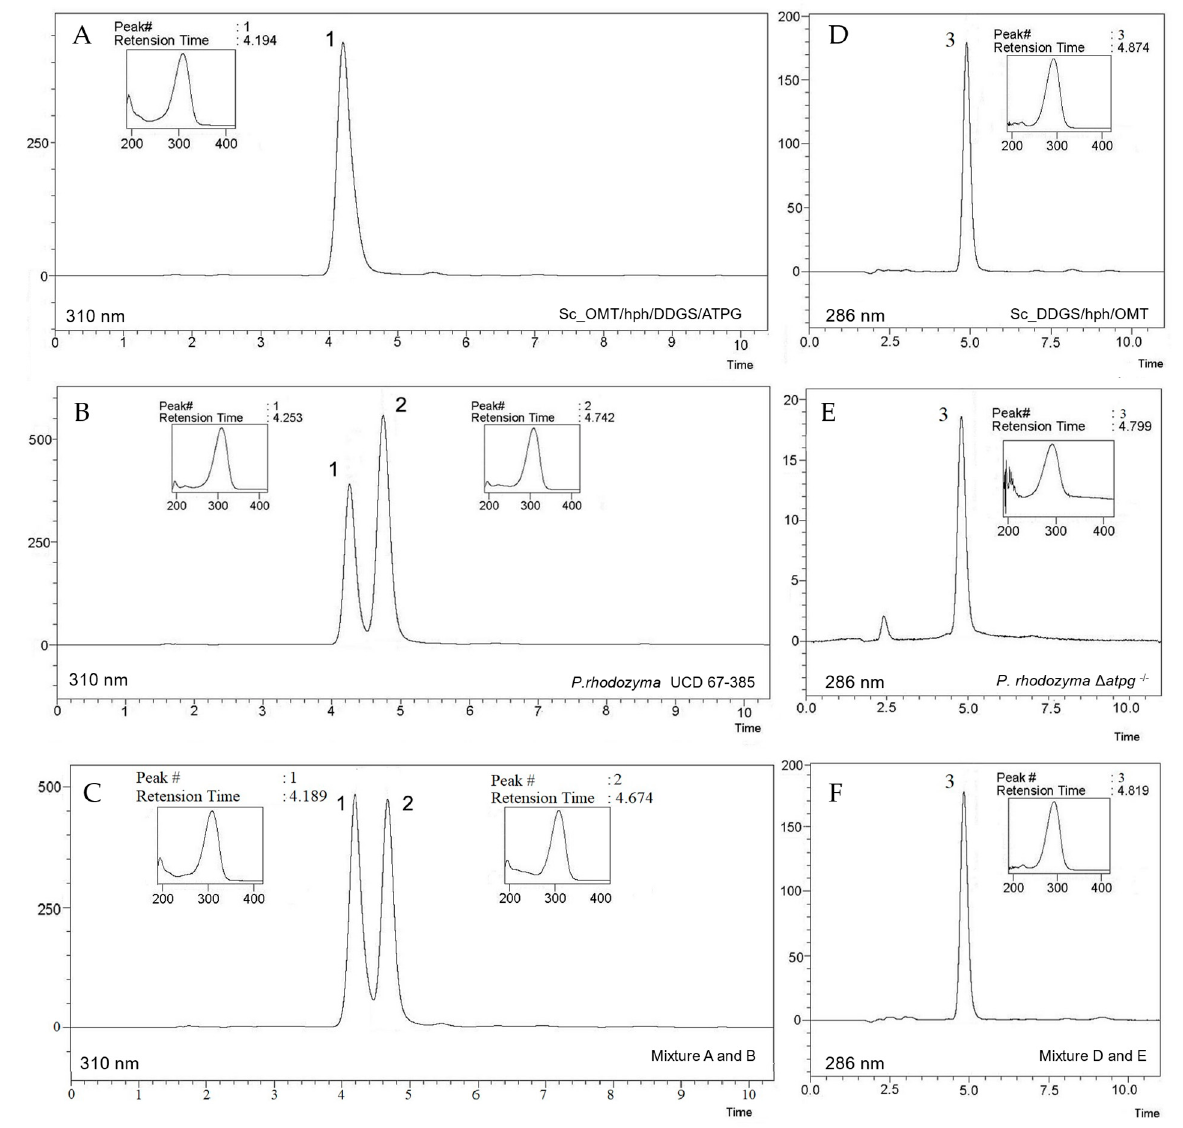
Figure 3. RP-HPLC analyses of mycosporines from S. cerevisiae . Representative chromatograms of mycosporines synthesized by heterologous expression of P. rhodozyma genes in S. cerevisiae . Peaks: 1 mycosporine glutaminol, 2 mycosporine glutaminol glucoside, 3 4-deoxygadusol. Samples from ( A ) Sc_OMT/hph/DDGS/ATPG, ( B ) P. rhodozyma , and ( C ) mixture of A and B. Samples from ( D ) 4DG extracted of Sc_DDGS/hph/OMT, ( E ) P. rhodozyma ∆ atpg − / − , and ( F ) mixture of D and E. Insets represent the spectrophotometric scan of each peak.